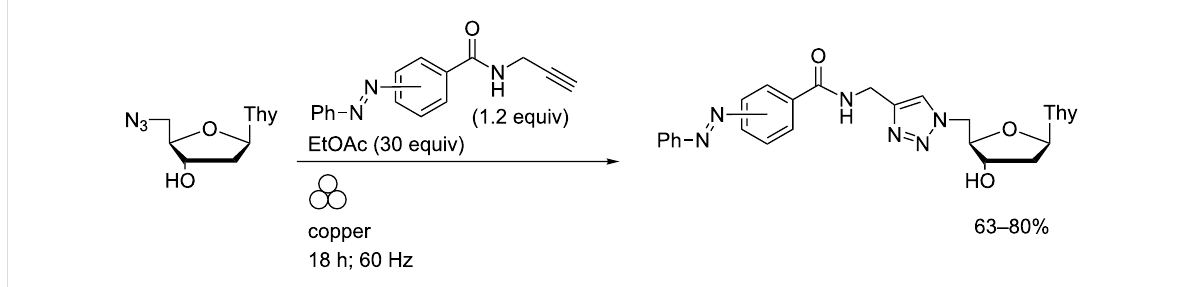
Expeditious displacement of tosylate or halides from 5 ′ -deriva- tised nucleosides was achieved using chalogenate nucleophiles in a mixer ball mill using zirconia components [22]. Highly efficient transformations to the corresponding 4-methoxy- benzyl thioethers were achieved in 15–60 minutes such that pure products could be isolated without the need for chromatog- raphy (Scheme 7). Of particular note was the absence of any observable intramolecular cyclisation of the unprotected purine